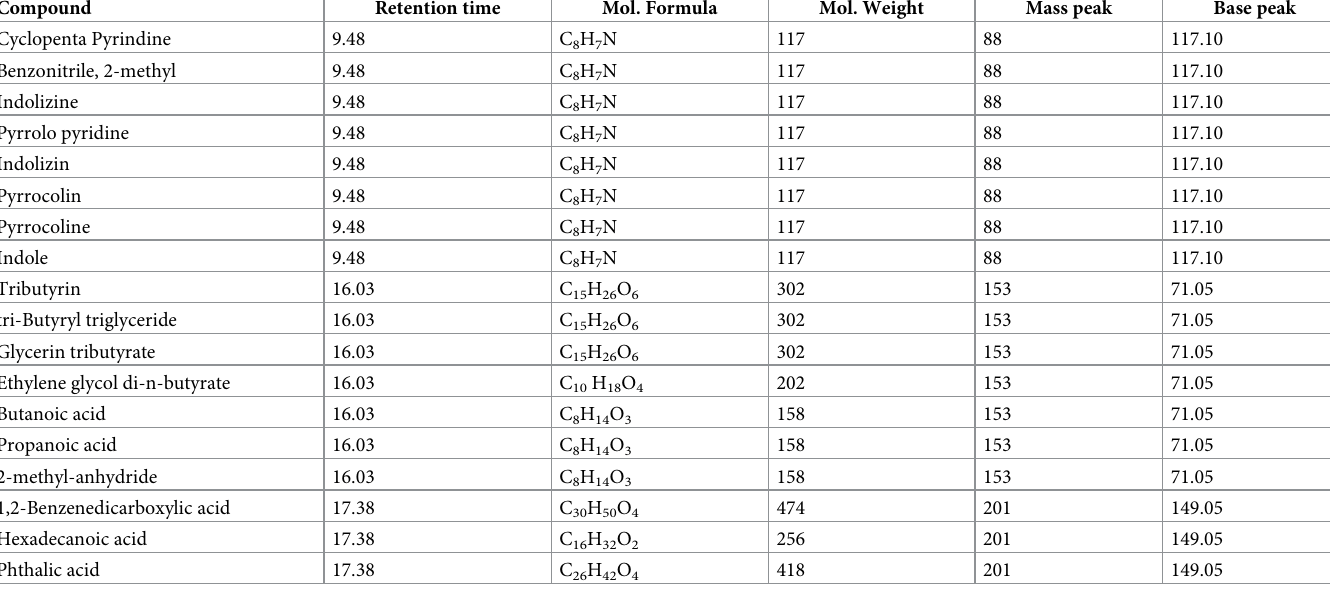
Table 1. Indole compounds identified in secondary metabolites of Pseudomonas aeruginosa MK 513749 in GCMS. Compound Retention